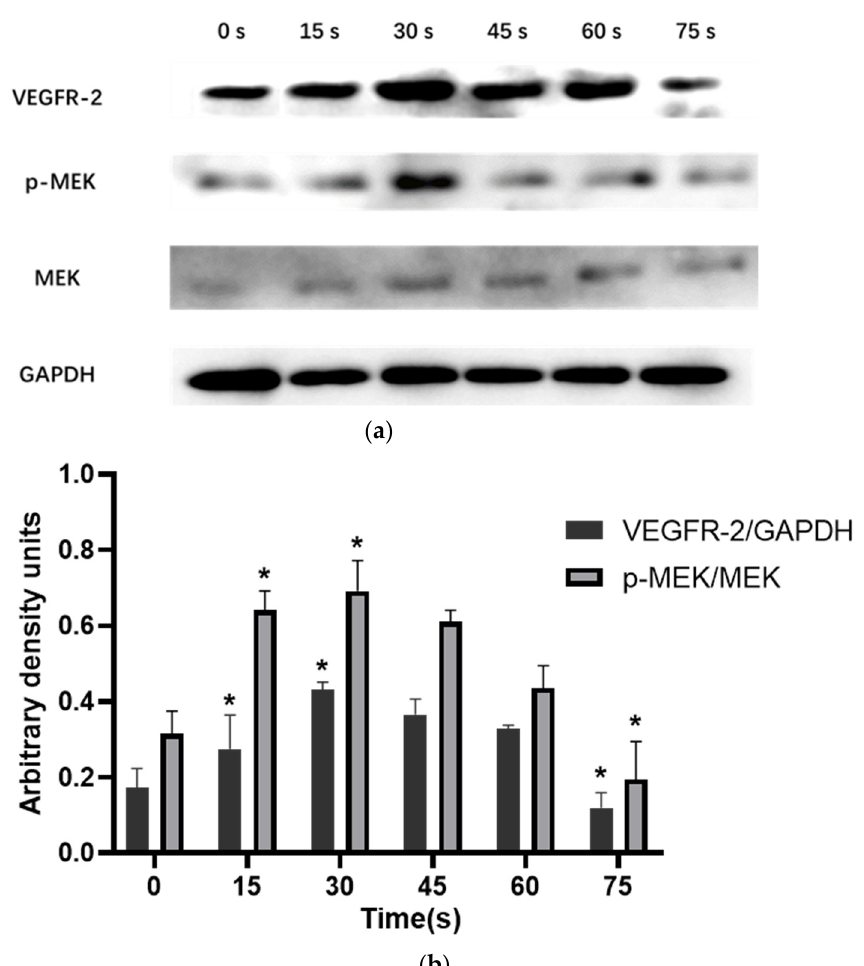
Figure 7. ( a ) Protein expression bands detected with Western blotting. ( b ) Statistical results, *